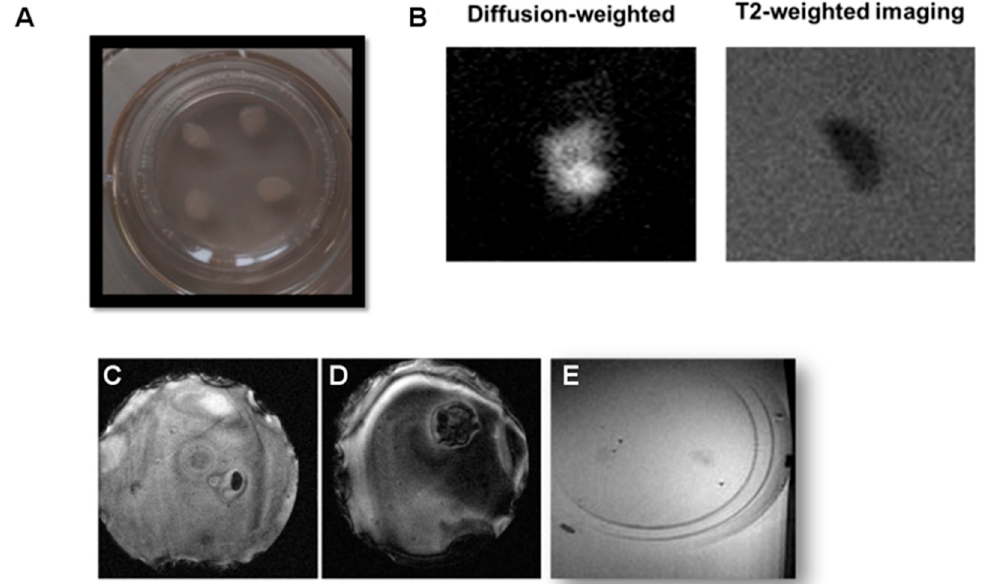
Figure 4. MR imaging of thin organotypic slices. ( A ) A photograph of organotypic slices in culture. ( B ) Diffusion-weighted vs. T2-weighted imaging of an organotypic slice. ( C – E ) Different imaging artifacts observed when imaging thin tissue slices (( C ) air bubble; ( D ) misalignment of the supporting membrane with imaging plane; ( E ) loss of CNR due to partial volume effects).